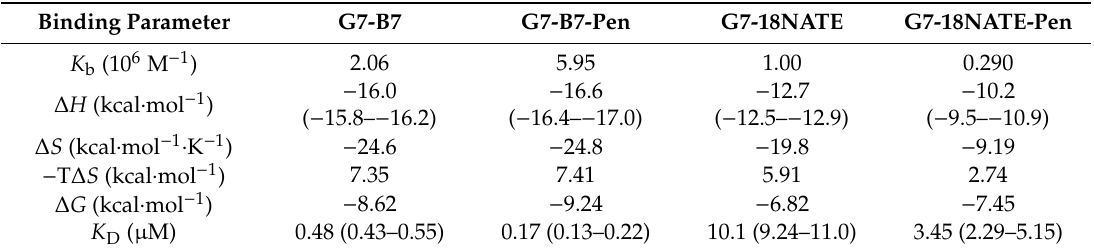
Table 1. Thermodynamic parameters of Grb7 targeting peptides binding to the Grb7-SH2 # .